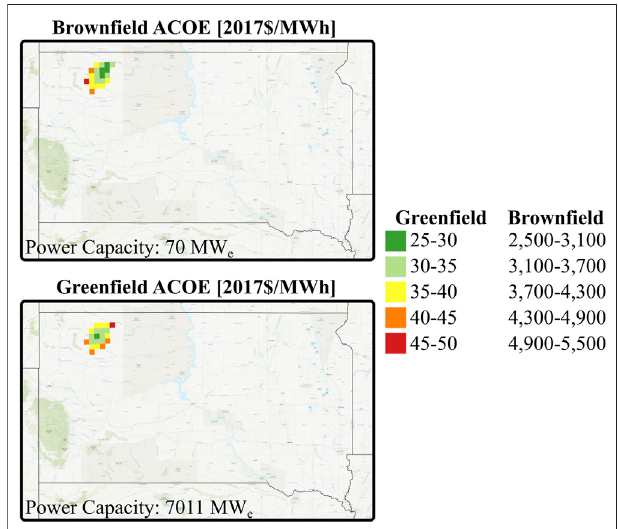
FIGURE 5 | Additional Cost of Electricity (ACOE) for Brown fi eld and Green fi eld Development Across the South Dakota CPG “ Sweet Spot ” When the Capacity Factor is